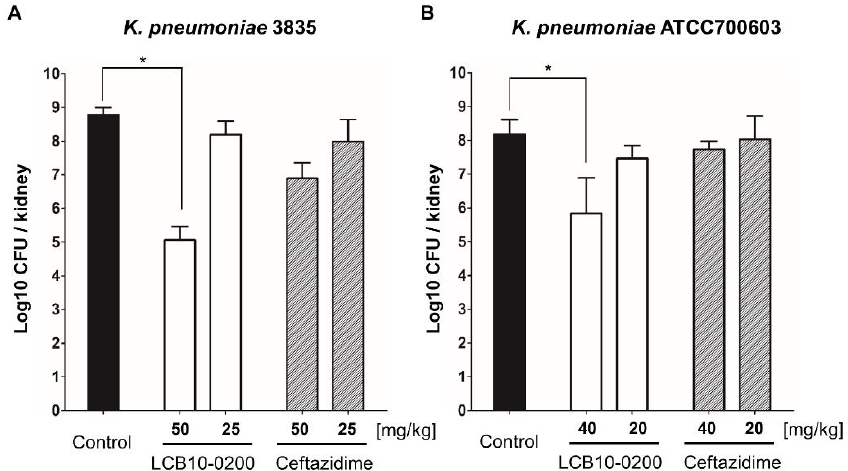
Figure 3. In vivo activity of LCB10-0200 in the urinary tract infection mouse model. Therapeutic efficacies of LCB10-0200 and ceftazidime in the urinary tract infection mouse model against two ceftazidime-resistant K. pneumoniae strains (( A ) K. pneumoniae 3835; ( B ) K. pneumoniae ATCC700603). Each bar represents mean ± SD (standard deviation of the mean; n = 3; * p < 0.05).